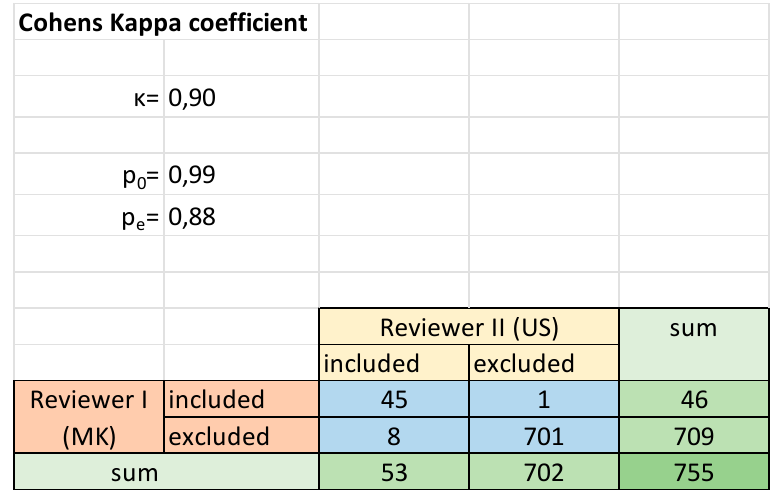
Table 1. Cohens Kappa coefficient calculation . Figure A1. Cohens Kappa coe ffi cient